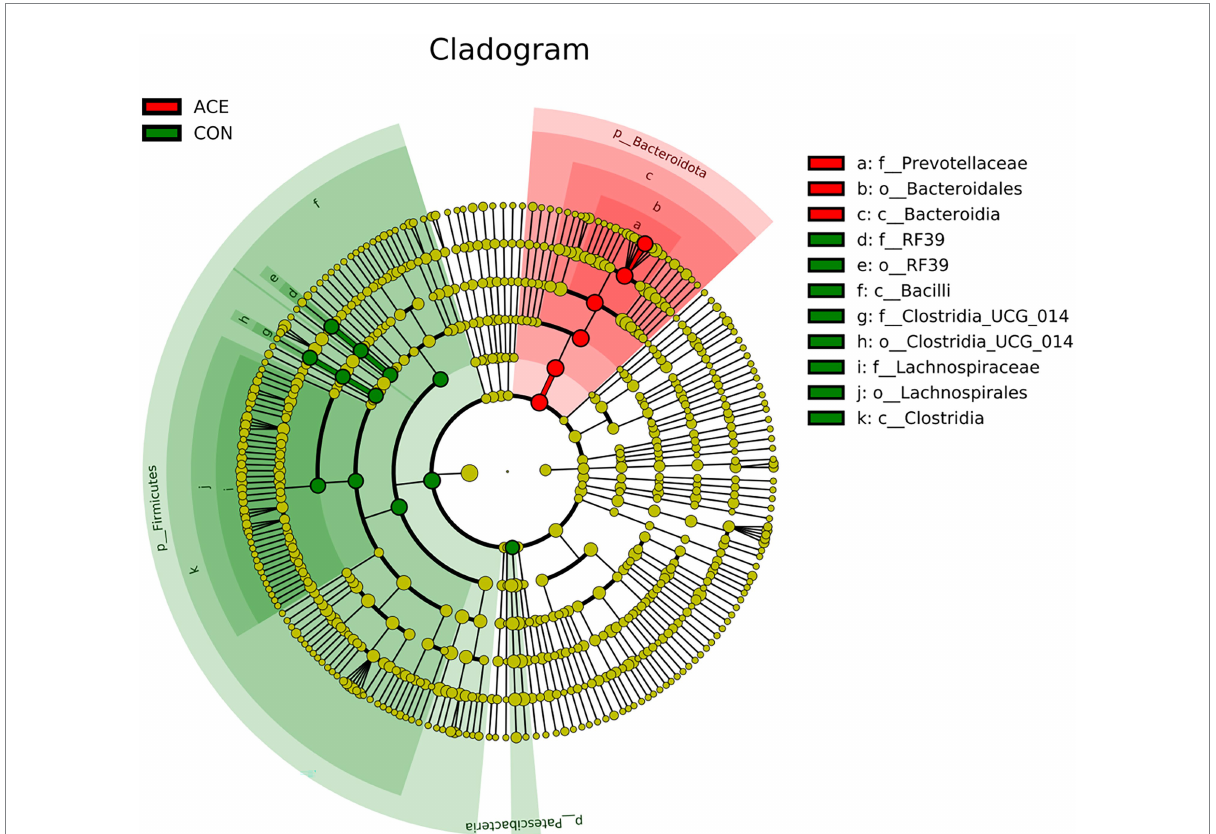
FIGURE 4 Linear discriminant analysis effect size (LEfSe) analysis to identify biomarker genera within the rumen microbial community of diets supplemented with NAc. Nodes indicate the position of microbial groups within taxa, and circles and axes indicate the number of taxa at the level of the taxon and at lower levels. Letters provided prior to the microbial taxa associated with the taxonomic level (p_: phylum; c_: class; o_: order; f_: family; g_: